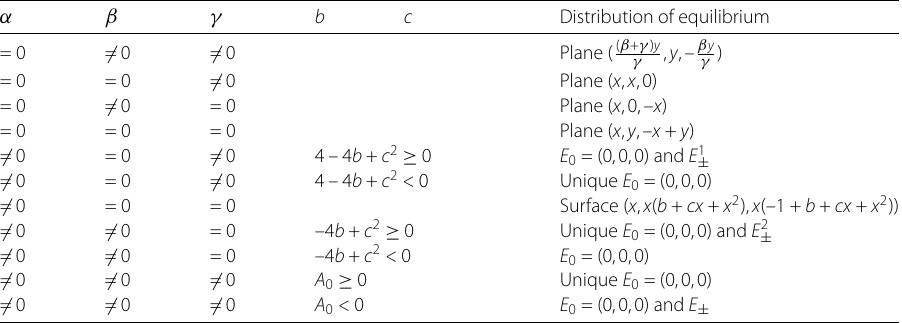
Table 1 The distribution of equilibrium of system (1)